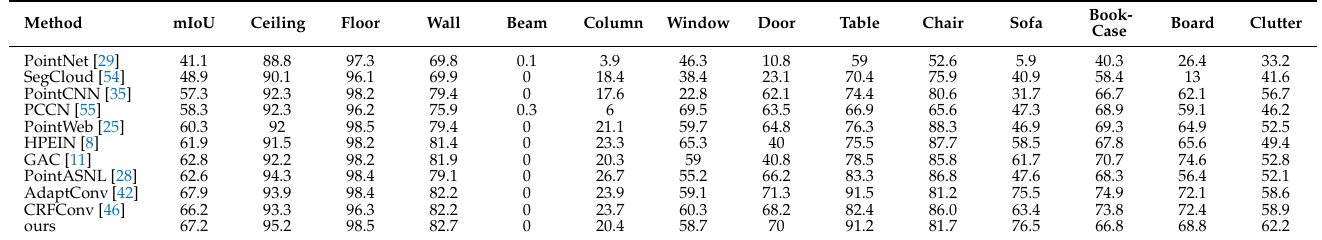
Figure 5. Visualization of semantic segmentation results on S3DIS Area-5. The first column shows original scene inputs, the second column shows the ground truth annotations, and the third column shows the scenes segmented by our proposed model GC-MLP. Table 3. Semantic segmentation results on S3DIS dataset evaluated on Area 5. We report the mean classwise IoU (mIoU ( % )